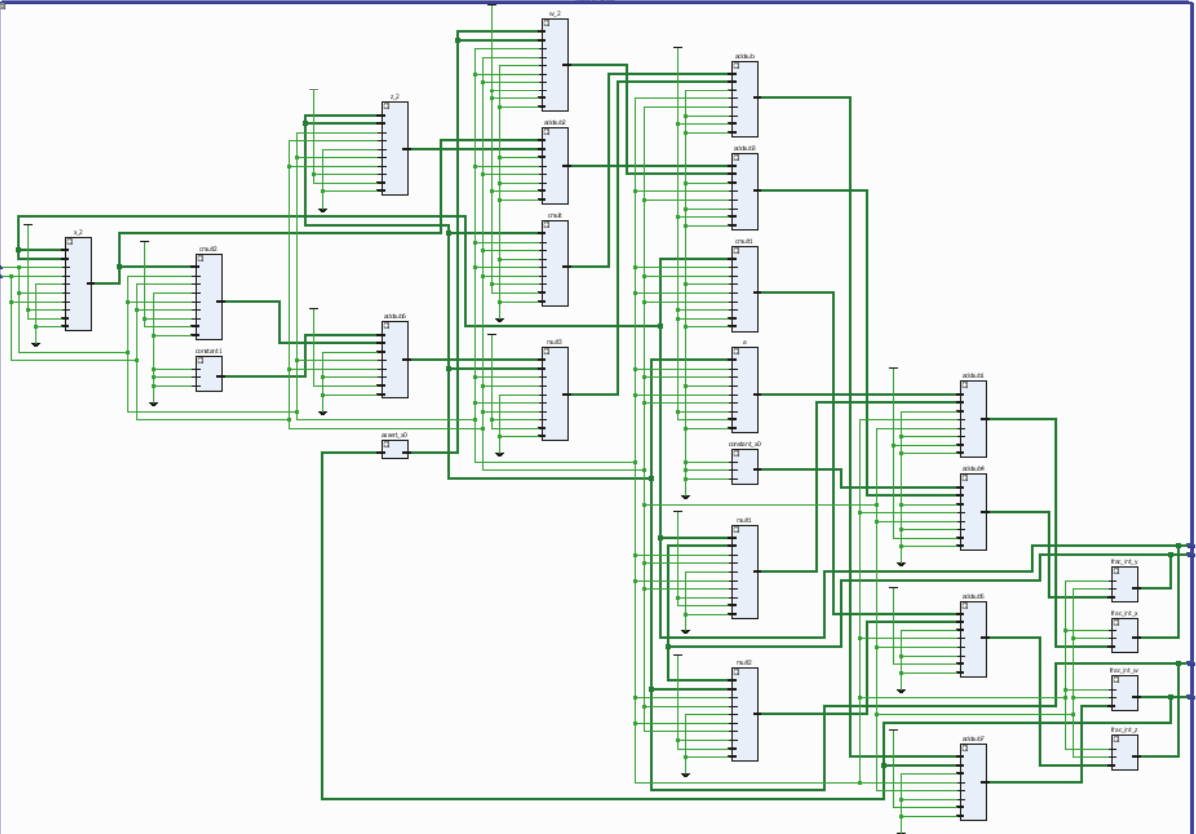
Figure 14: Xilinx schematics of the FOSG system implemented in Kintex 7 (device = 7k160t; package = fbg484 S).